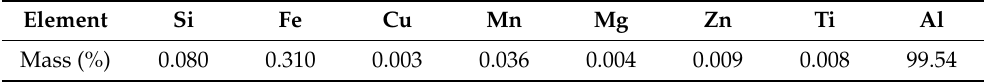
Table 1. Chemical composition in %mass of 1050 aluminium alloy